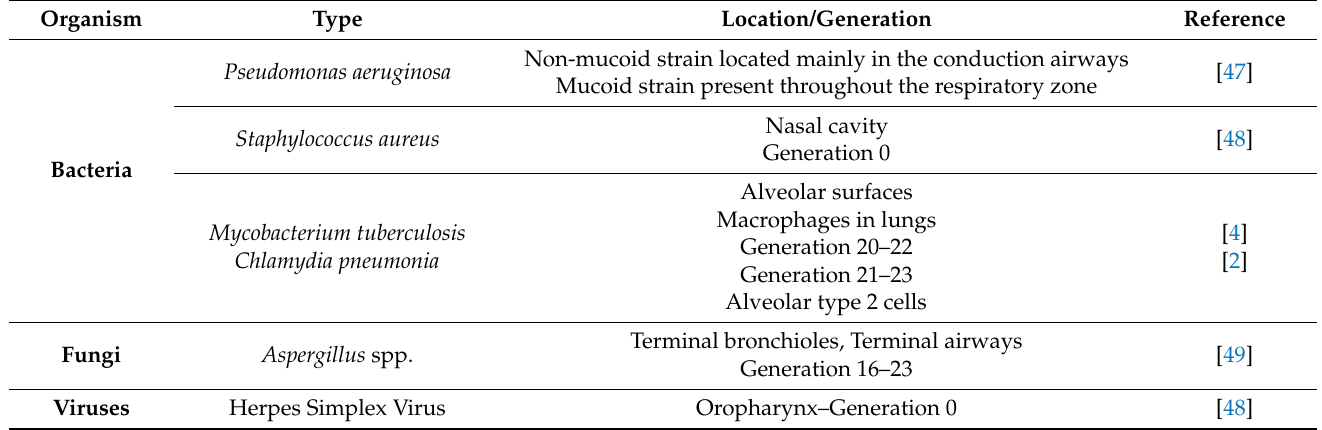
Table 3. Location of infections causative microorganisms within the respiratory